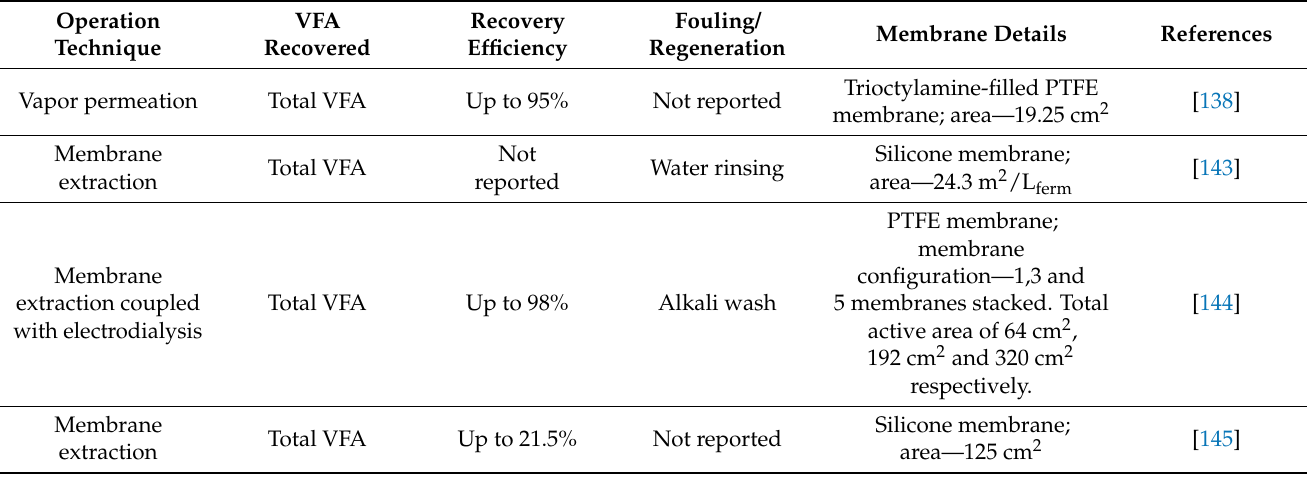
Table 4. Summary of recent works on VFA recovery using membrane-based